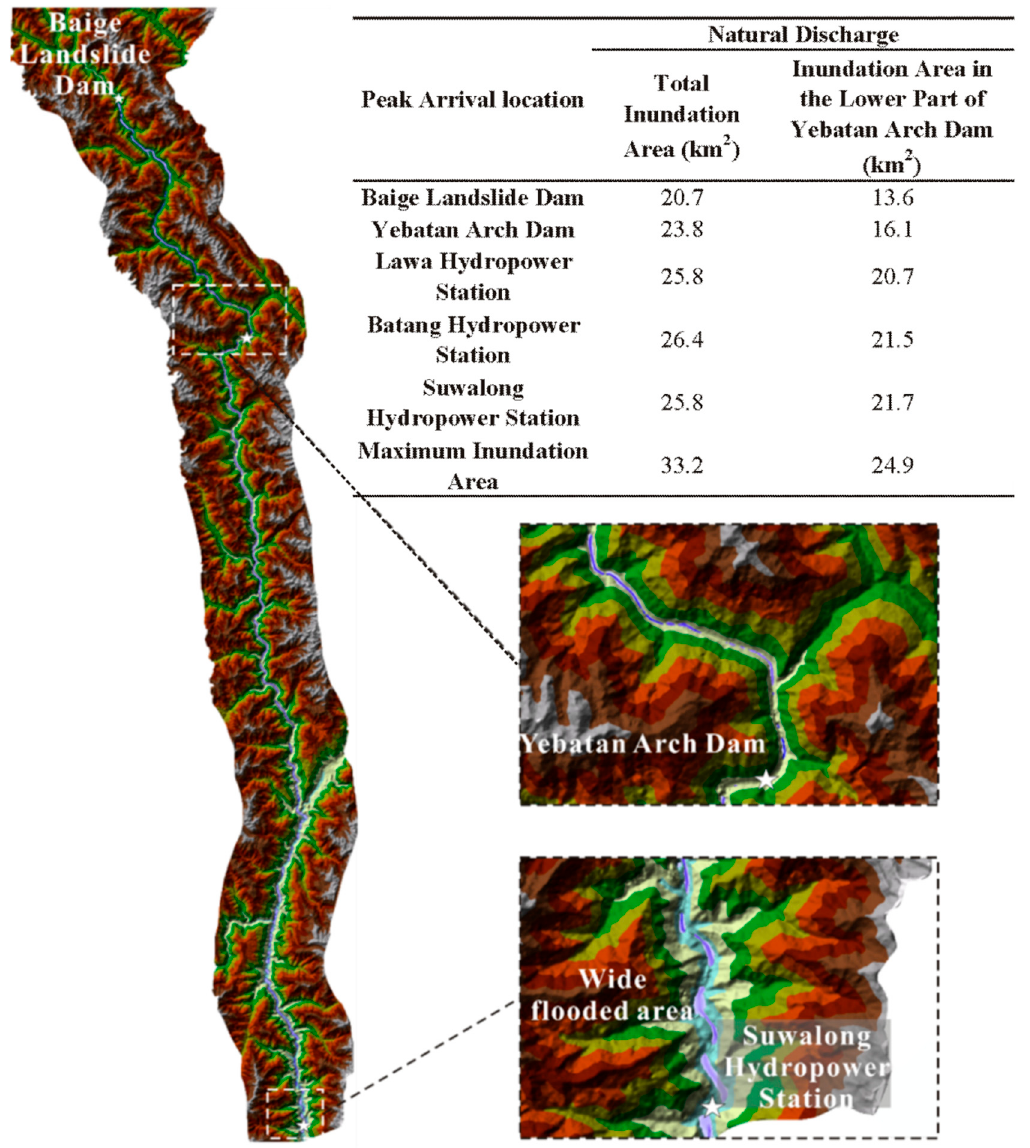
Figure 7. Three-dimensional display of the maximum inundation area when naturally discharging (in the table, the inundation area of natural discharge).